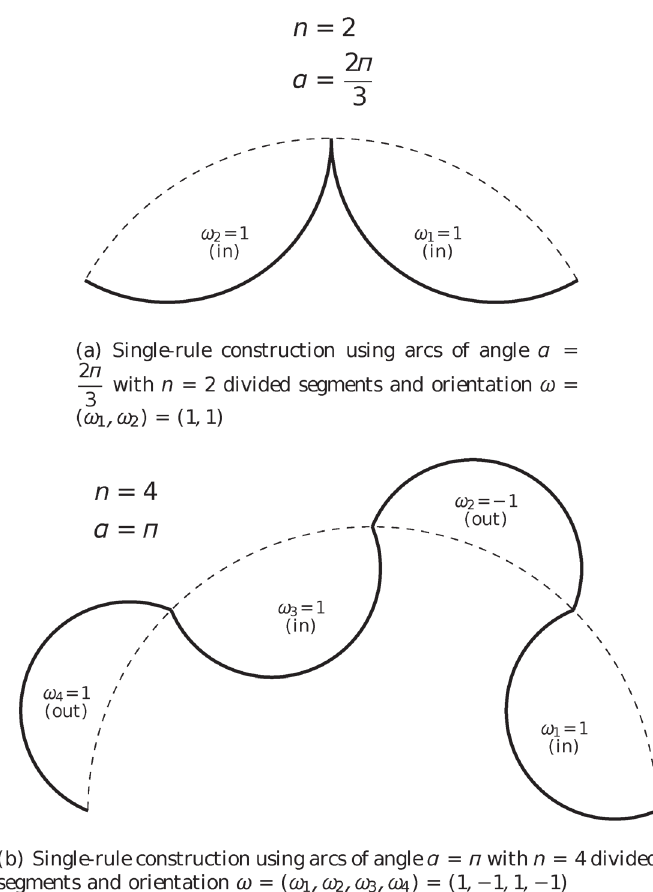
Fig 2. Illustration of the parameters α , n and ω in the construction of fractals using the arc-fractal system.